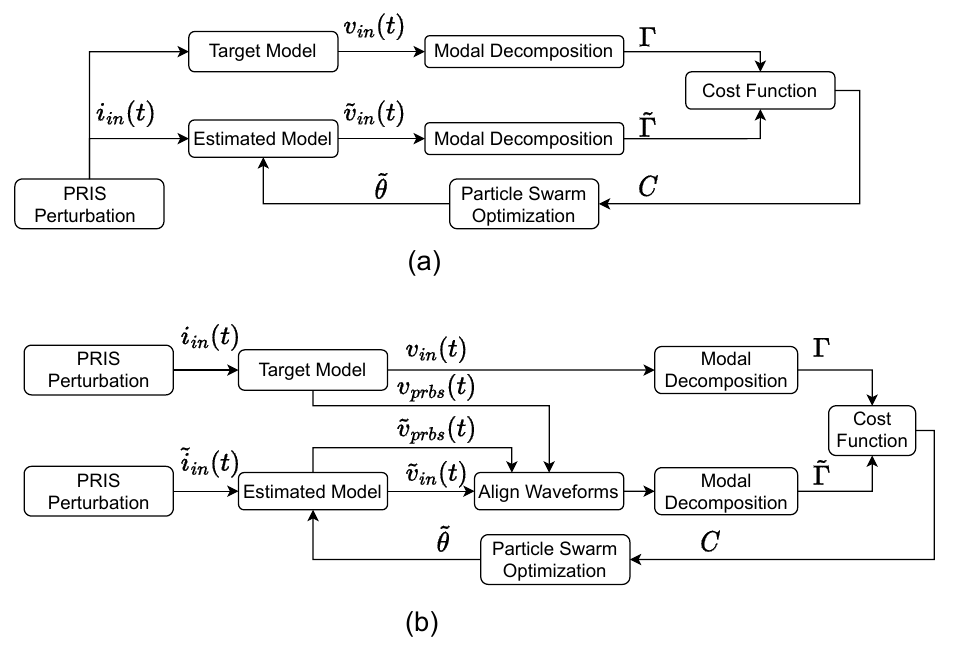
Figure 5. Time-domain Modal Decomposition Parameter Estimation Methodology: ( a ) Alignment Strategy 1 and ( b ) Alignment Strategy 2.